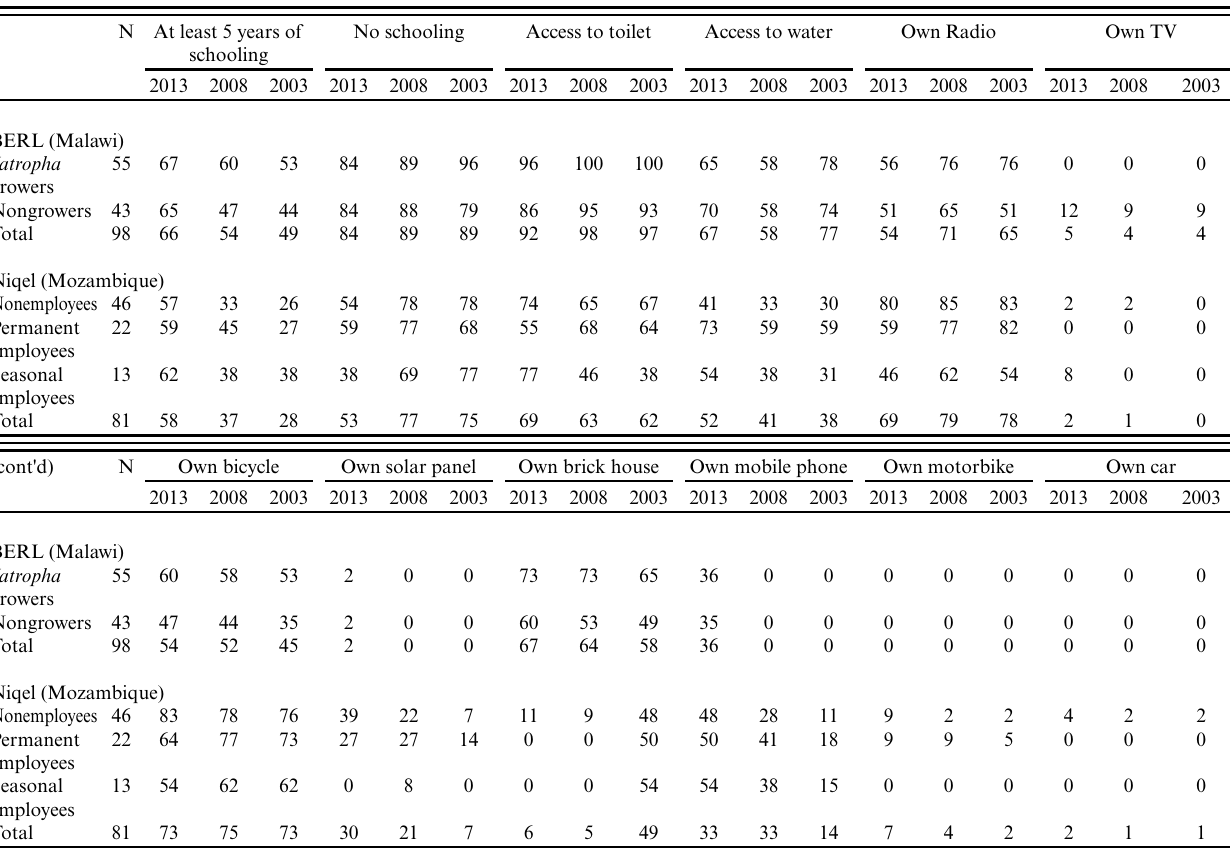
Table 12 . Multidimensional poverty indicators for each study group